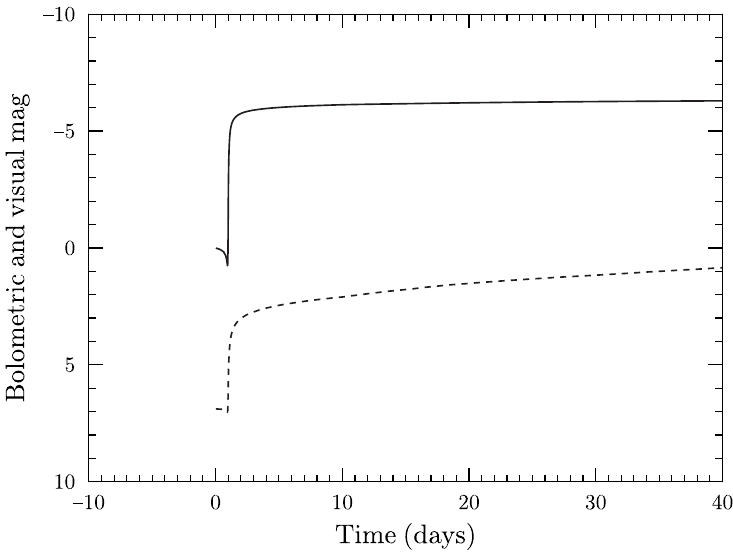
Fig. 9. The same as in Figure 7 but for 1.0 M ⊙ .